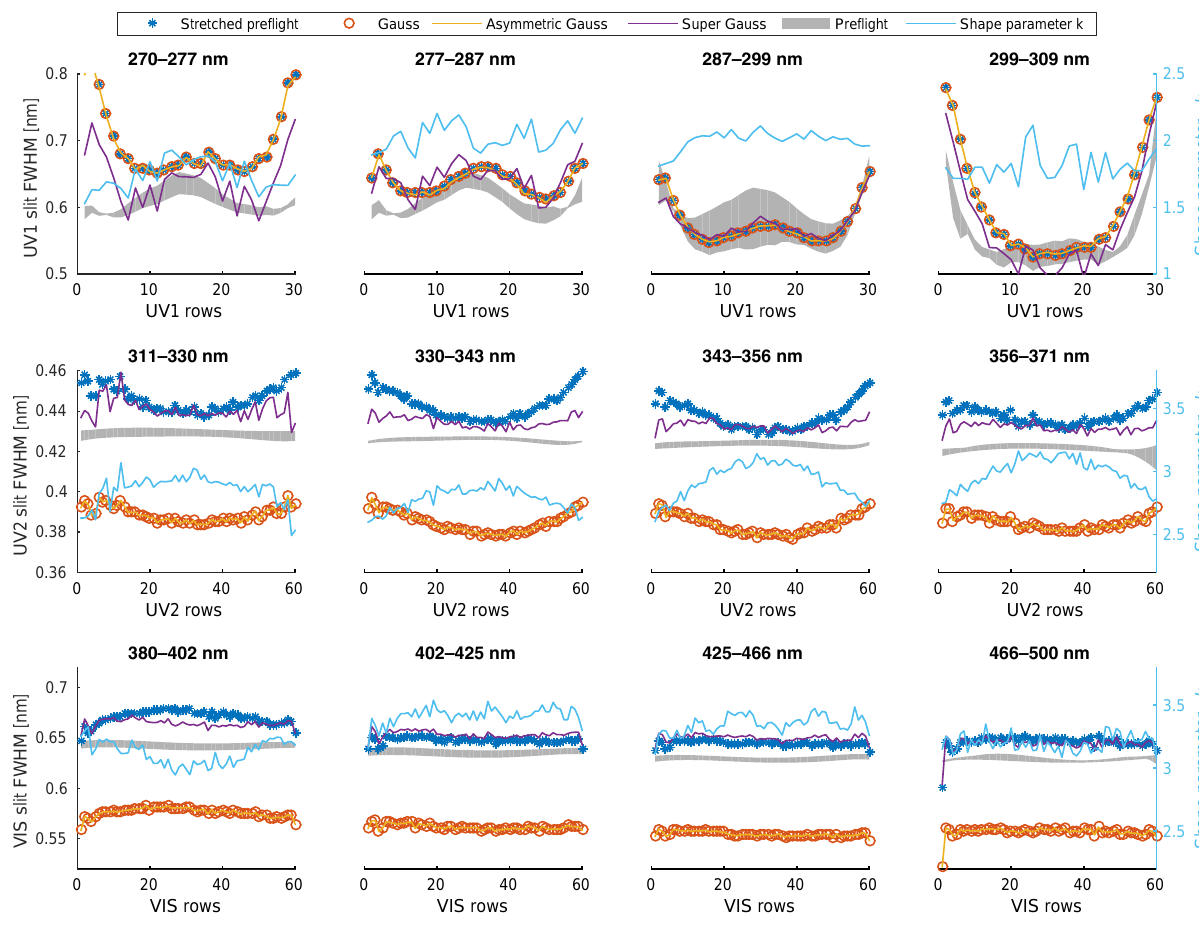
Figure A2. Similar to Fig. 3 but using averaged solar spectra from January 2010 to September 2012.